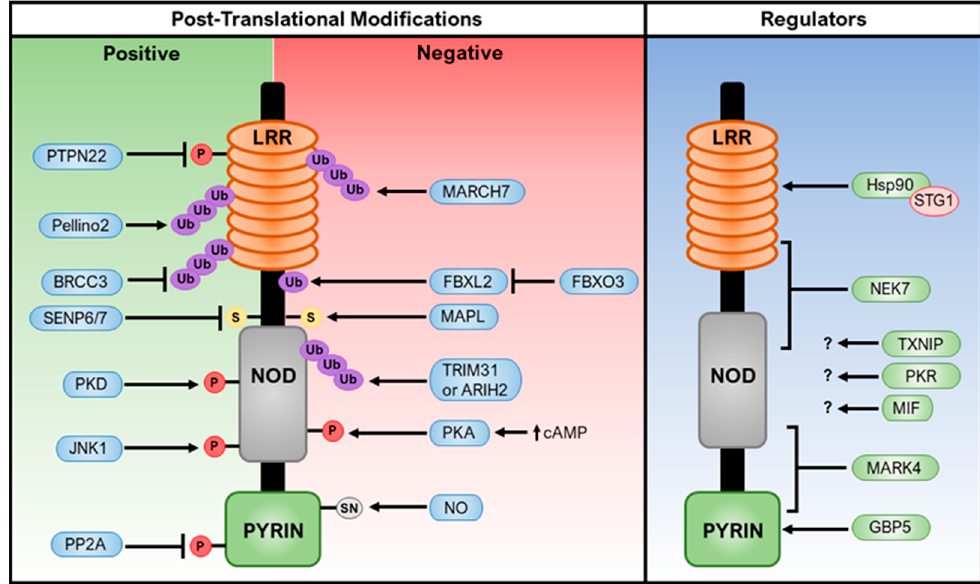
Figure 3. Post-translational Modifications and Regulators of NLRP3. NLRP3 is regulated via phosphorylation (P), ubiquitination (Ub), sumolyation (S), and s-nitrosylation (SN) through post-translational modifications. Post-translational modifications that positively affect NLRP3 activation are listed on the left and those that negatively act on NLRP3 to inhibit its activation are listed in the middle. Interacting partners of NLRP3 are listed on the right. ARIH2, ariadne homolog 2; BRCC3, BRCA1/BRCA2-containing complex subunit 3; FBX12, F-box/LRR-repeat protein 2; FBXO3, F-box only protein 3; JNK1, JUN N-terminal kinase 1; MAPL, mitochondrial-anchored protein ligase; MARCH7, membrane-associated RING finger protein 7; NO, nitric oxide; PKA, protein kinase A; PKD, protein kinase D; PP2A, phosphatase 2A; PTPN22, protein tyrosine phosphatase non-receptor 22; SENP6/7, sentrin/SUMO-specific proteases. GBP5, guanylate-binding protein 5; Hsp90, heat-shock protein 90; MARK4, microtubule-affinity regulating kinase 4; MIF, macrophage migration inhibitory factor; NEK7, NIMA-related kinase 7; PKR, double-stranded RNA-dependent protein kinase; STG1, suppressor of the G2 allele of skp1; TXNIP, thioredoxin-interacting